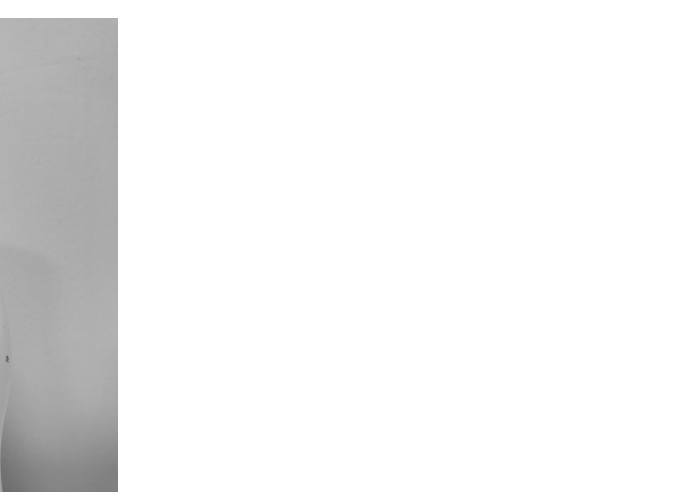
Figure 4. Calibration pattern wrapped around a cap; the sample was used for calibration of the system.